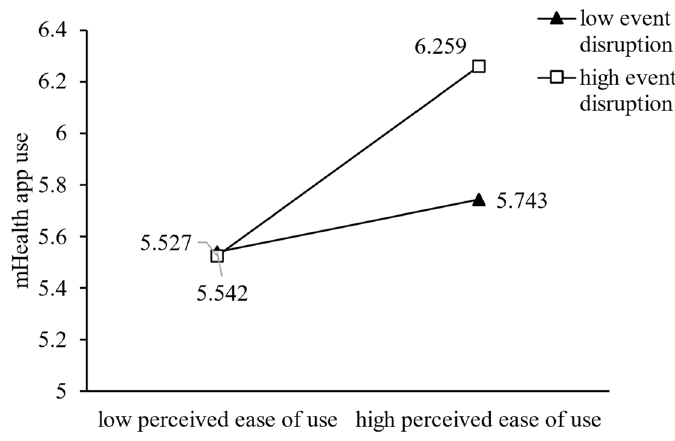
Figure 5. The Moderating Effect of Event Disruption on Perceived Ease of Use.